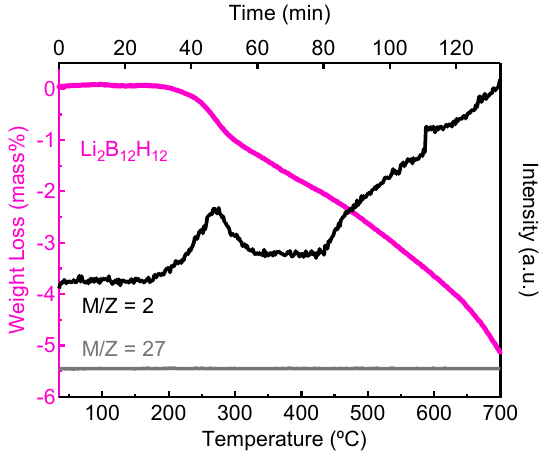
Figure 1. Thermogravimetry (TG) curve and mass spectrometry (MS) signals of anhydrous Li 2 B 12 H 12 (mass numbers 2 and 27 represent H 2 and B 2 H 6 ). Table 1. Relative amount of the B-H species in synthesized Li 2 B 12 H 12 when heated up to respective temperatures ( ≤ 500 °C), estimated from the peak fitting of 11 B MAS NMR spectra shown in Figure 3.